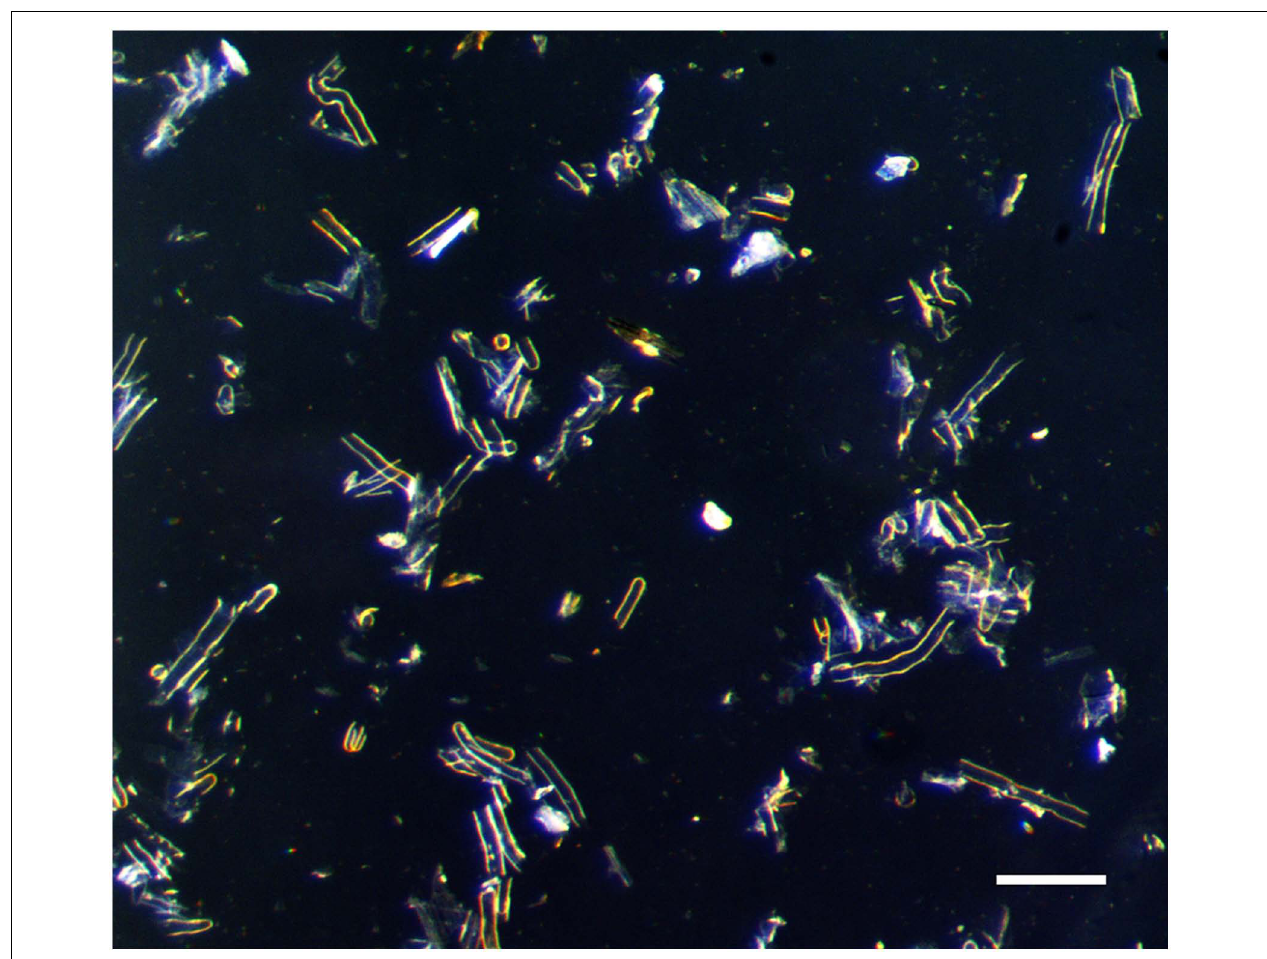
FIGURE 3 | Isolated root hairs in light microscope. Bar = 100 μ